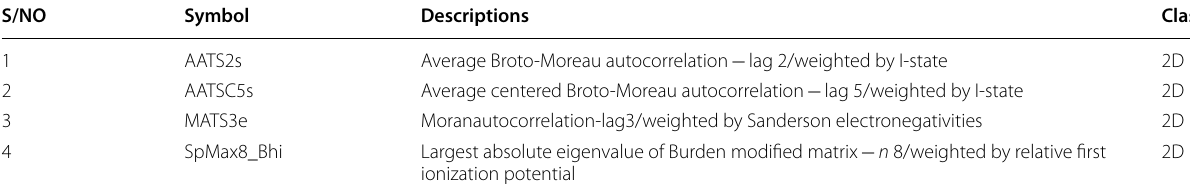
Table 3 List of independent variables (descriptors), their descriptions and class for model 1